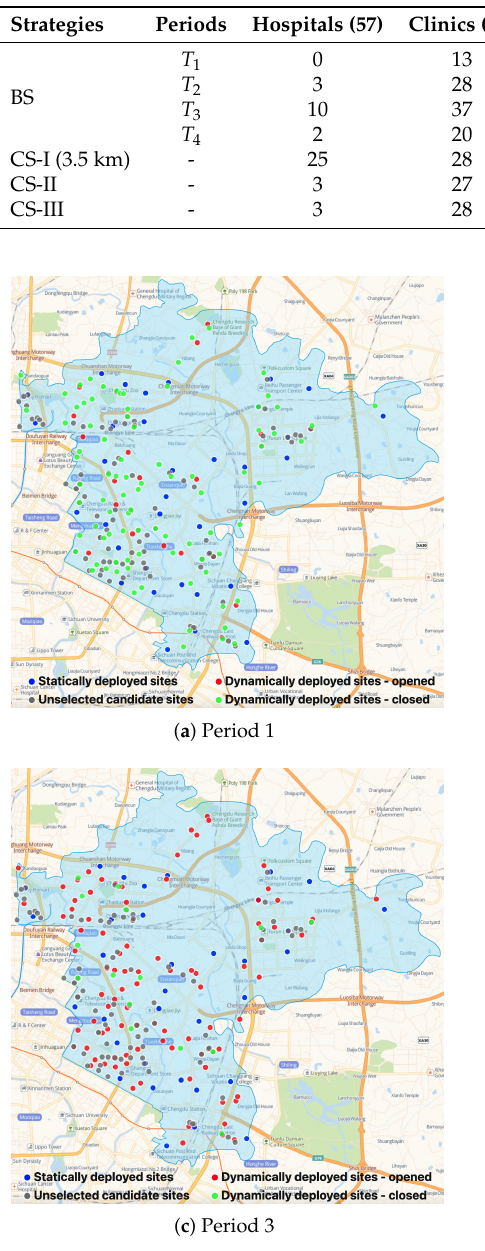
Figure 5. The dynamic site deployment of